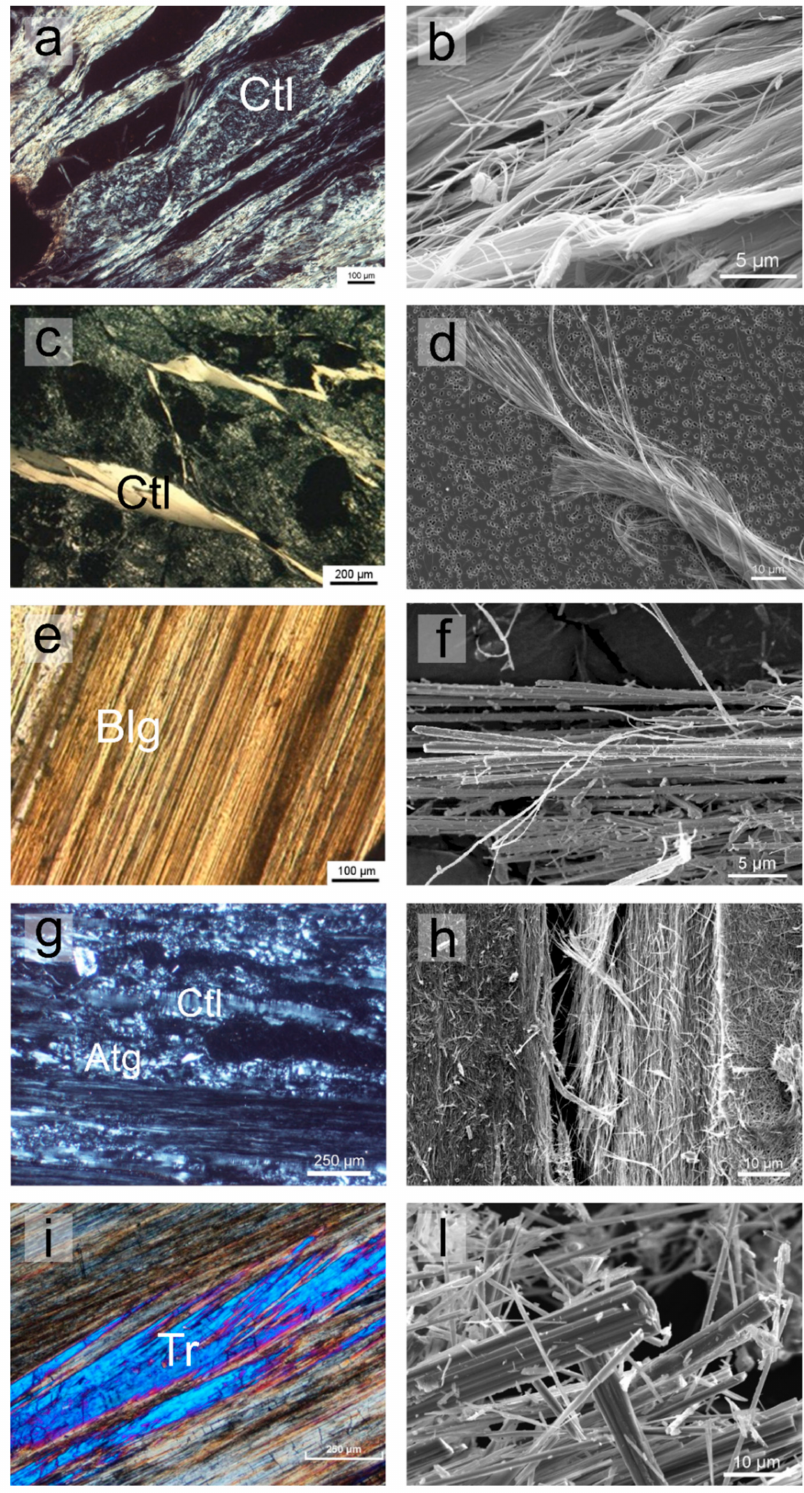
Figure 2. Petrographic and morphological (SEM images) description of representative NOA-bearing samples. Optical photomicrographs (cross-polarized light images on the left) and SEM images (on the right) showing: ( a , b ) Valmalenco quarry. Veins of slip long-fiber chrysotile; ( c , d ) Balangero mine. Veins of slip chrysotile; ( e , f ) Balangero mine. Bundle of balangeroite fibers; ( g , h ) Tontouta Ni-open pit. Bundle of chrysotile and fibrous antigorite; and ( i , l ) Tontouta Ni-open pit. Bundle of tremolite fibers. Abbreviations: Ctl, chrysotile; Blg, balangeroite; Atg, antigorite; Tr,